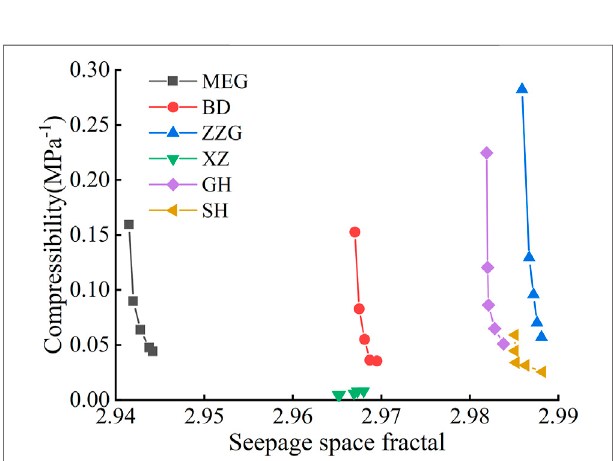
FIGURE 11| Relationship between compressibility and heterogeneity of seepage